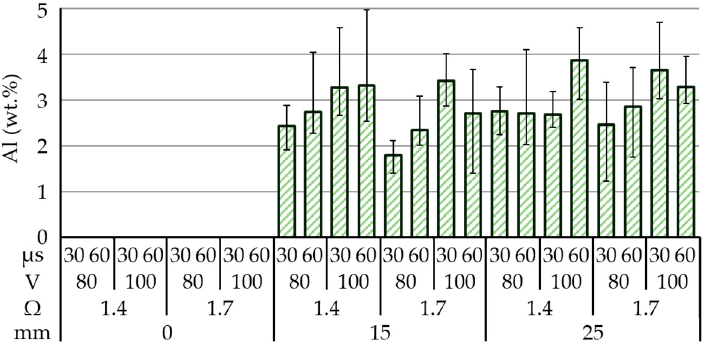
Figure 9. Surface modification of polycrystalline silicon as a function of source workpiece thickness.